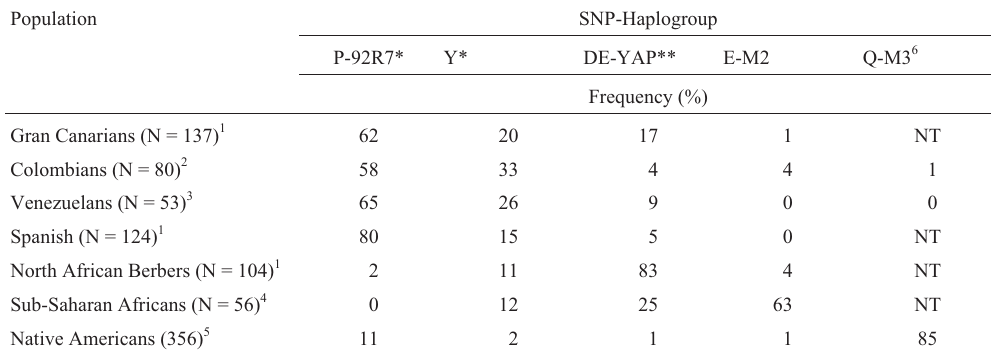
Table 1 - Y-chromosome biallelic haplogroups and their frequency in Gran Canarians and other human populations. Population SNP-Haplogroup